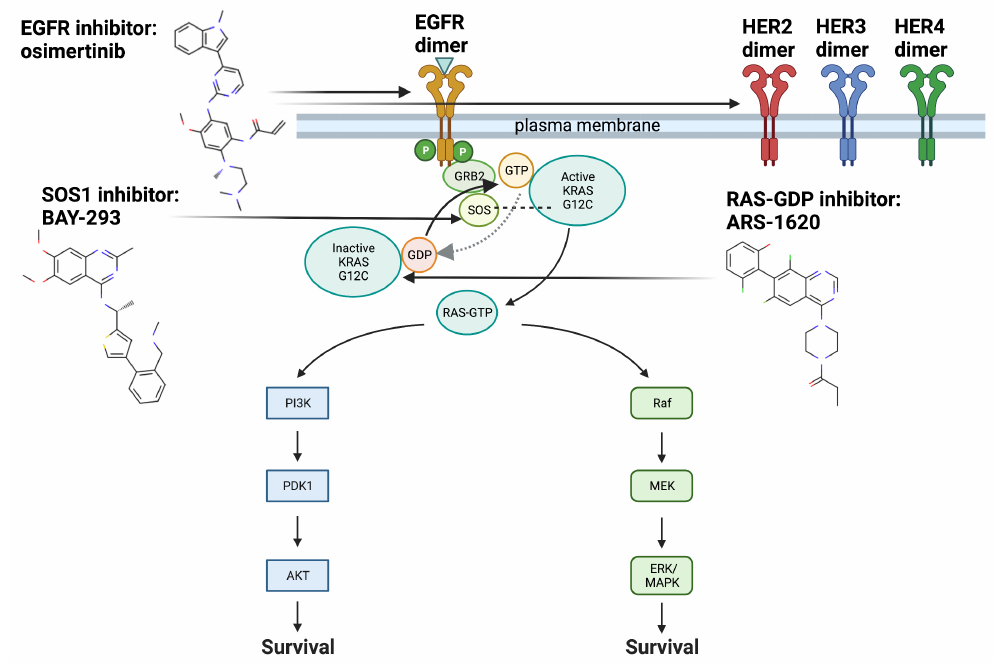
Figure 1. EGFR, SOS1, RAS and downstream pathways with drugs of interest and mechanisms of action. KRAS G12C undergoes biochemical changes that allow it to remain in its GTP-bound active state for longer periods of time, versus the inactive GDP-bound state: Increased time in the GTP-bound active state leads to increased activation of downstream signaling cascades involving Raf-MEK-ERK and PI3K-AKT-mTOR which are involved in cellular proliferation and survival [1]. Here we show the targets for inhibitors analyzed in this study, BAY-293, ARS-1620, osimertinib, and relevant downstream signaling pathways. BAY-293 targets the KRAS G12C-SOS1 interaction, which decreases the exchange of GDP to GTP involved in activating KRAS G12C. ARS-1620 targets GDP-bound KRAS G12C, and decreases the ability of SOS1 to exchange GDP to GTP. Osimertinib, predicted by our computational platform during the course of this study, acts upstream of KRAS G12C to inhibit EGFR, specifically the resitance-causing T790M mutation. It has also demonstrated activity against wild type EGFR and HER2, which have been implicated in adaptive resistance to KRAS G12C inhibition through re-activation of scaffold proteins. Although these three inhibitors (ARS-1620, BAY-293, osimertinib) have differing methods of action, it is possible they may synergize through shared targets that are as yet unknown. Created with